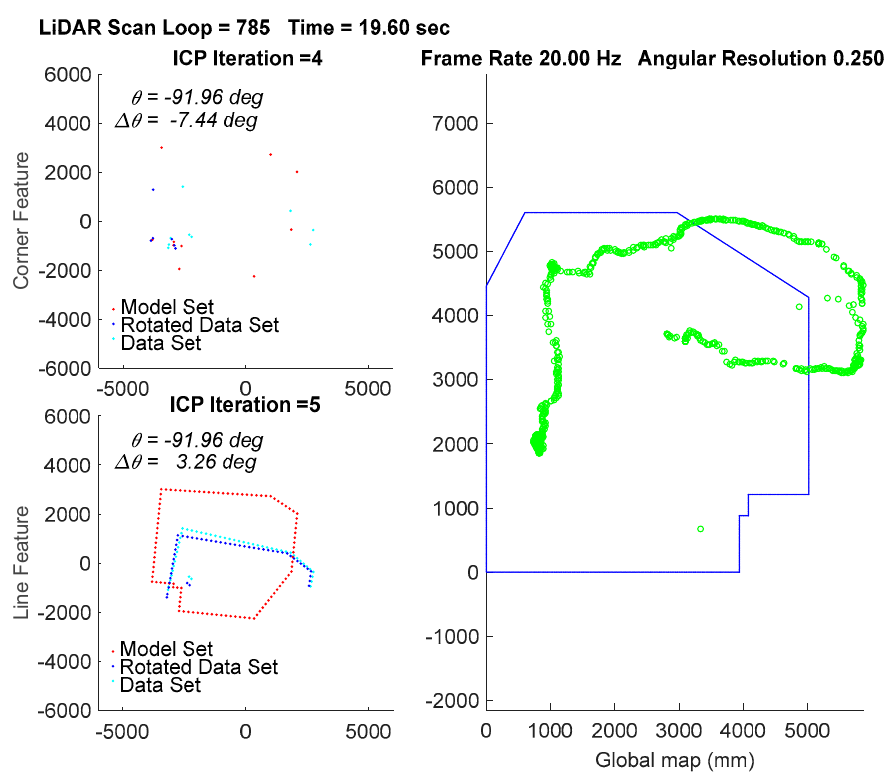
Figure 22. Localization result by using corner features only (where the line information was not fused for the localization).